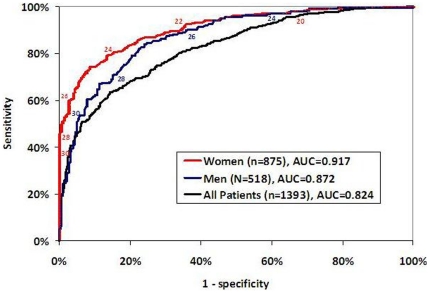
Receiver Operating Characteristic (ROC) Curve for Using BMI to Predict Obesity for Women.The area under the curve increases when stratified by sex. Numbers indicate the BMI cutoff value that corresponds to sensitivity/specificity along ROC curve. The BMI cutoff value that maximizes sensitivity and specificity is 24 for females (79% sensitivity and 87% specificity) and 28 for males (72% sensitivity and 83% specificity).